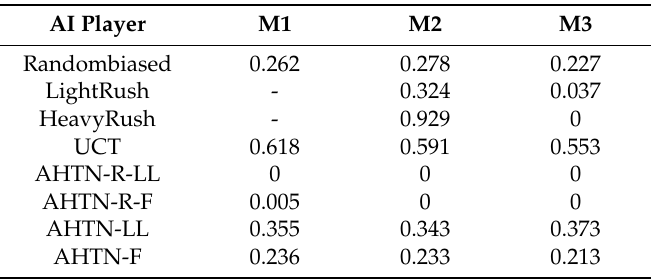
Table 3. Average repair rate of AHTN-R-LL against the 8 algorithms for the three map sizes. The symbol “-” indicates no failed tasks.